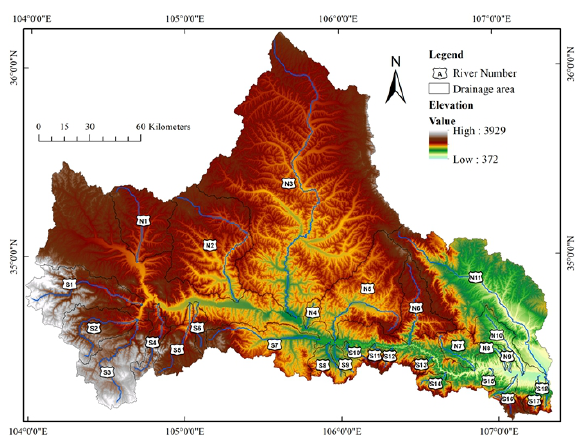
Figure 2. Distribution map of the main channels in URWR